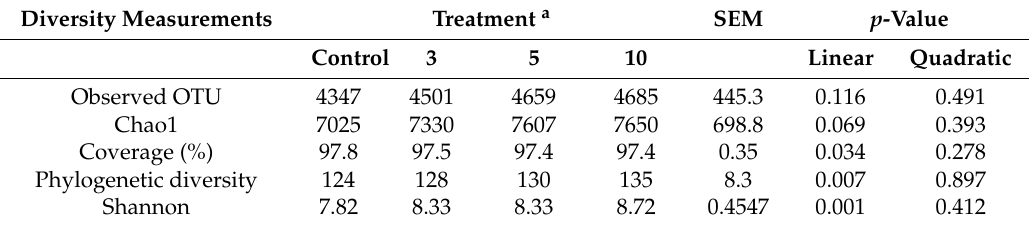
Figure 1. Bacterial community composition at the family level in the ruminal samples of sheep when fed a concentrate with di ff erent doses of spent co ff ee grounds ( n = 9 for spent co ff ee grounds group and n = 8 for control group). Table 1. E ff ect of di ff erent doses of spent co ff ee grounds on ruminal microbiota diversity measurements in lactating